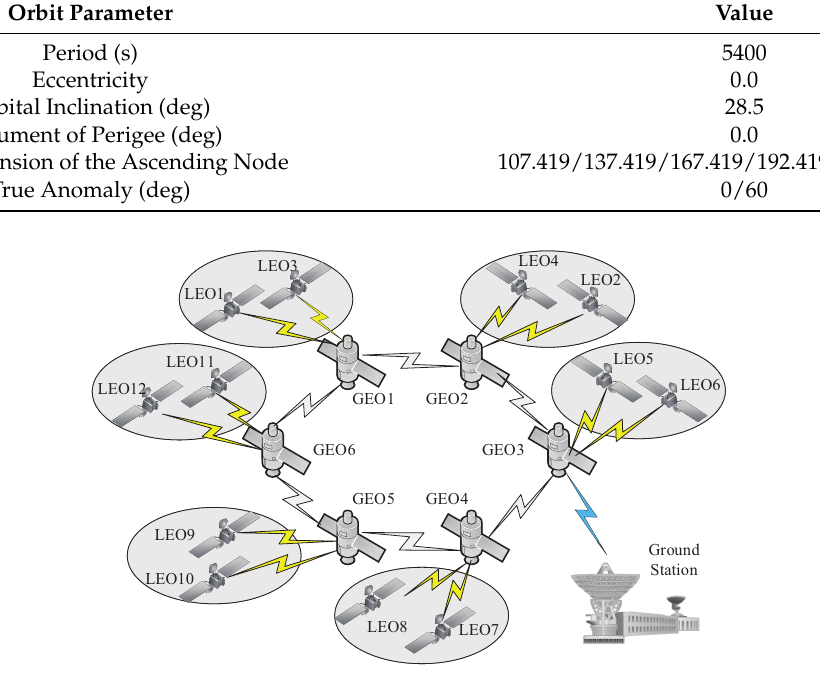
Table 6. LEO satellite orbit parameters and corresponding values.